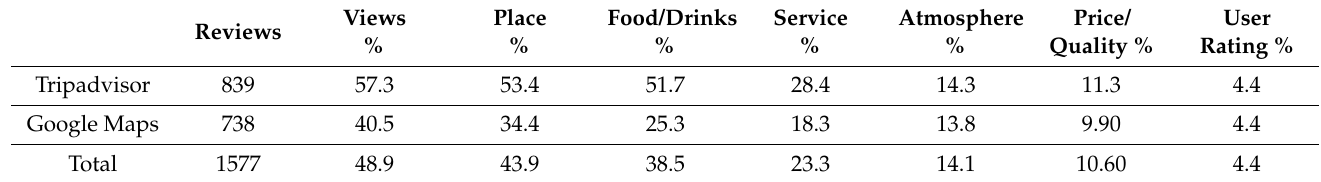
Table 2. Frequency of rooftop attributes according to user